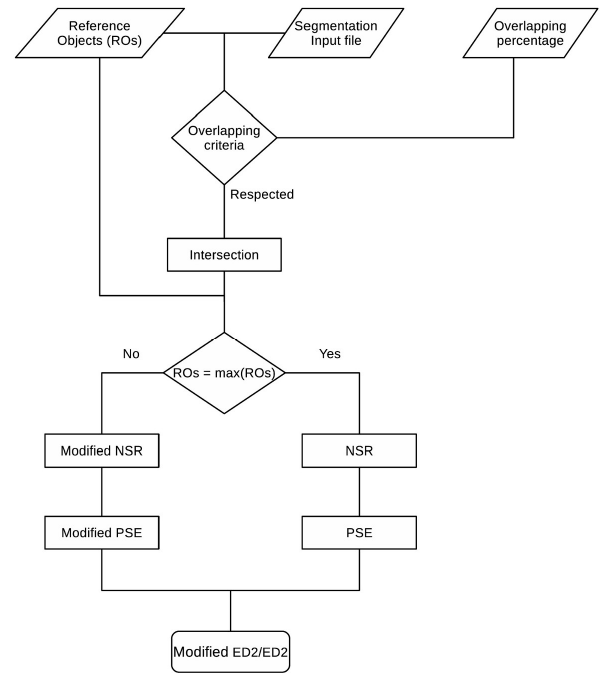
Figure 1. Flowchart of the core algorithm implemented in AssesSeg.